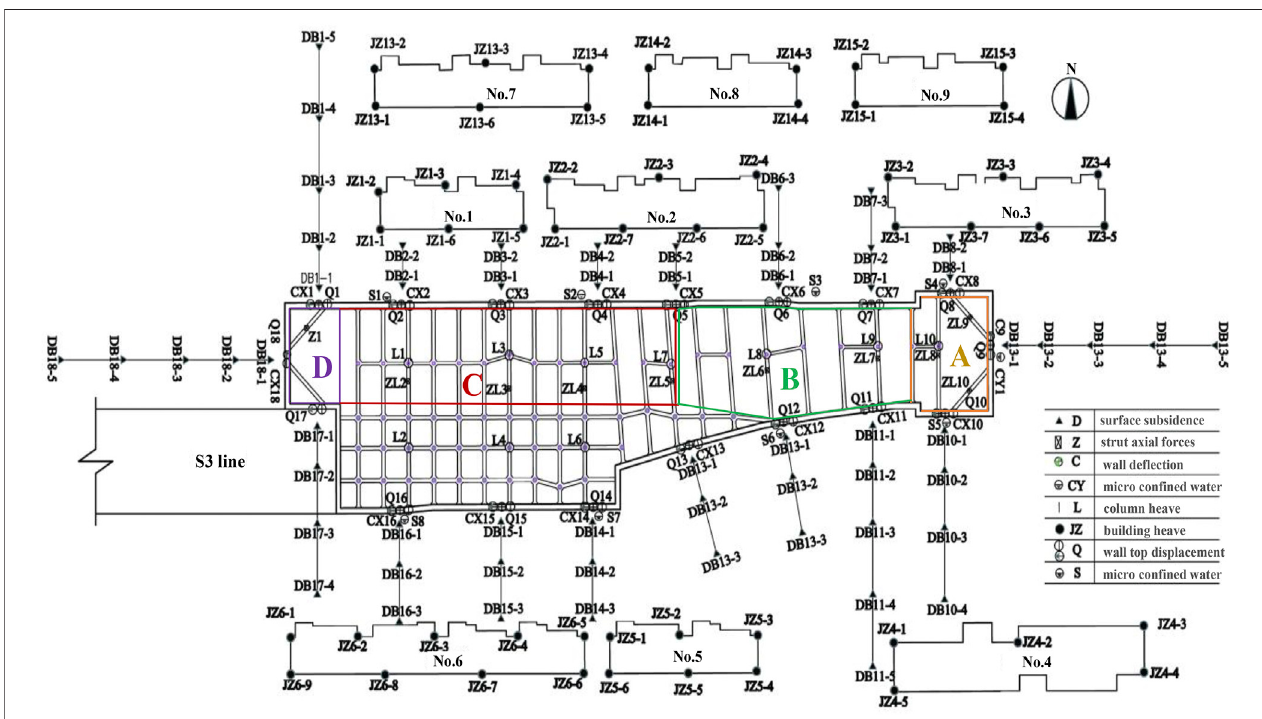
FIGURE 1 | Layout and zoning of foundation pit plane monitoring points.